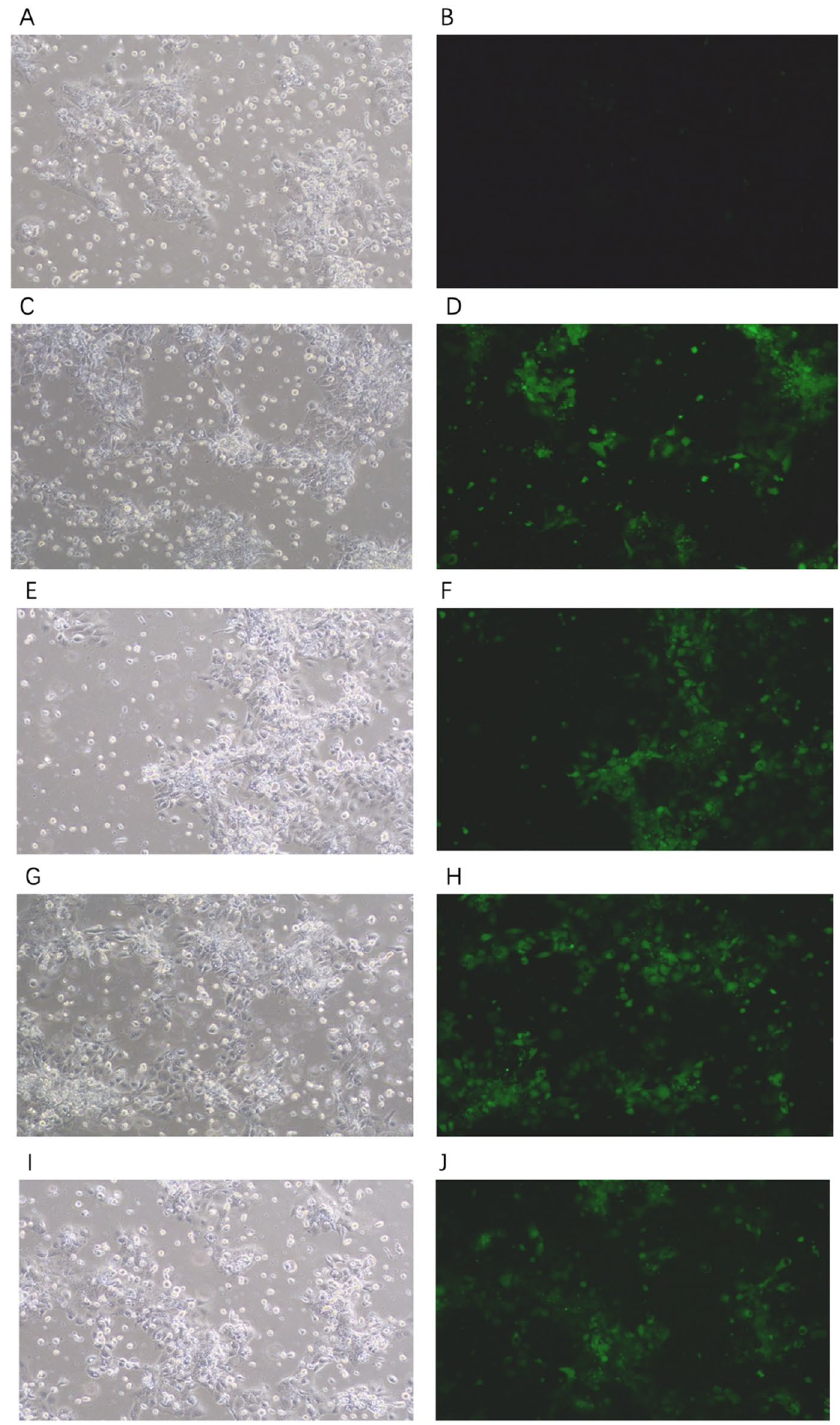
Figure 7. Different groups transfection efficiency. ( A , B ) The blank group; ( C , D ) the DJ‑1 overexpression group (expressed in DJ‑1 + / +); ( E , F ) the DJ‑1 + / + negative control group; ( G , H ) the DJ‑1 inhibited expression group (expressed in DJ‑1 −/−); ( I , J ) the DJ‑1 −/− negative control group. ( A , C , E , G , I ) the bright-field images; ( B , D , F , H , J ) the dark-field images (biological replicates number: